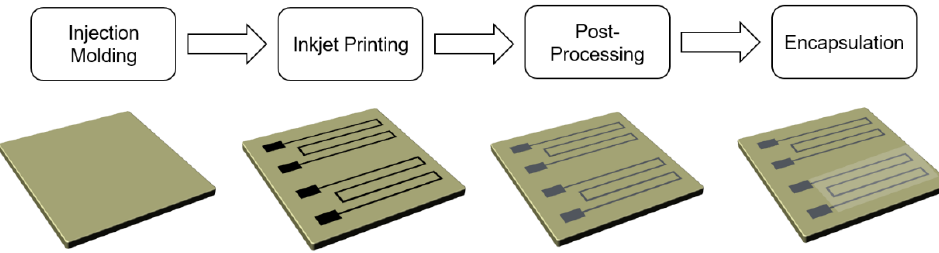
Figure 1. Scheme which demonstrates the processes for manufacturing of inkjet-printed tempera- ture